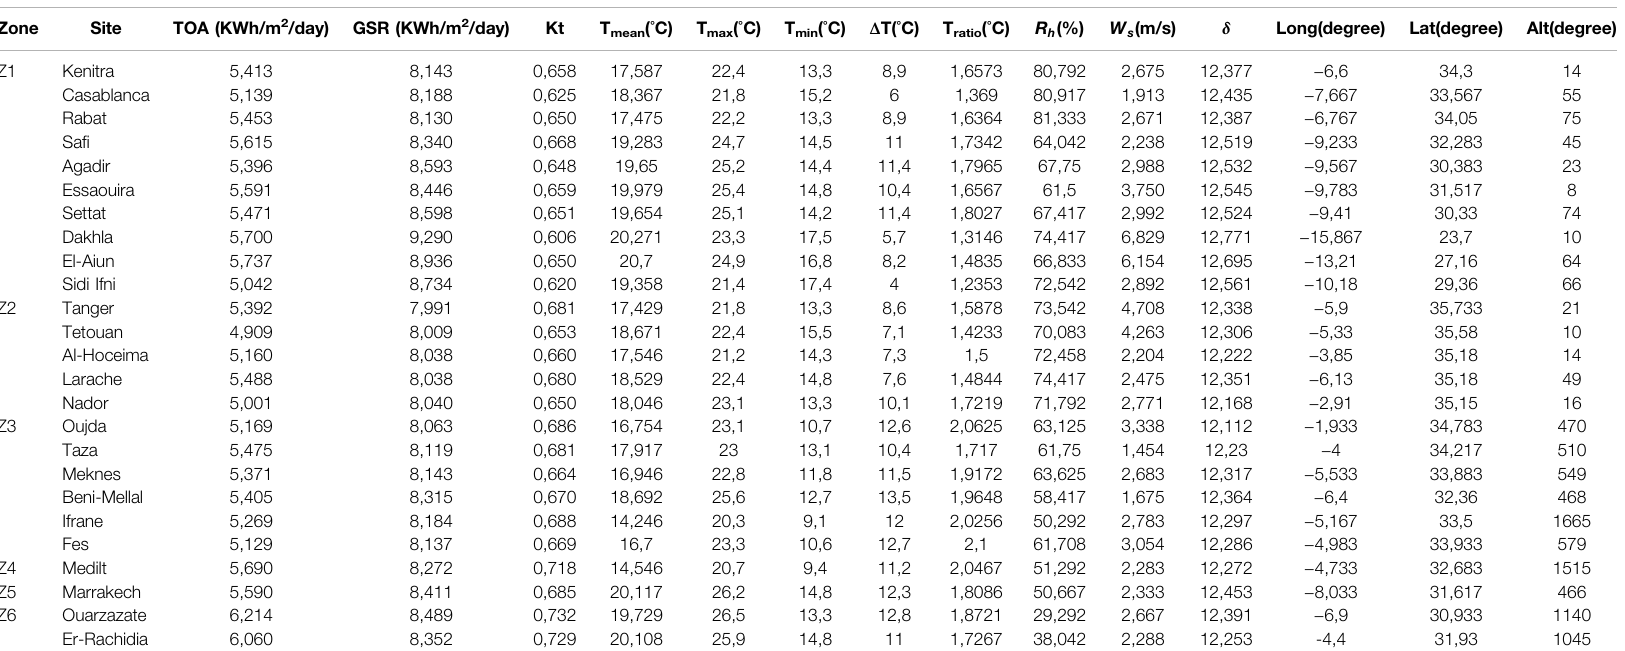
TABLE 2 | Average data of 25 locations and geographical